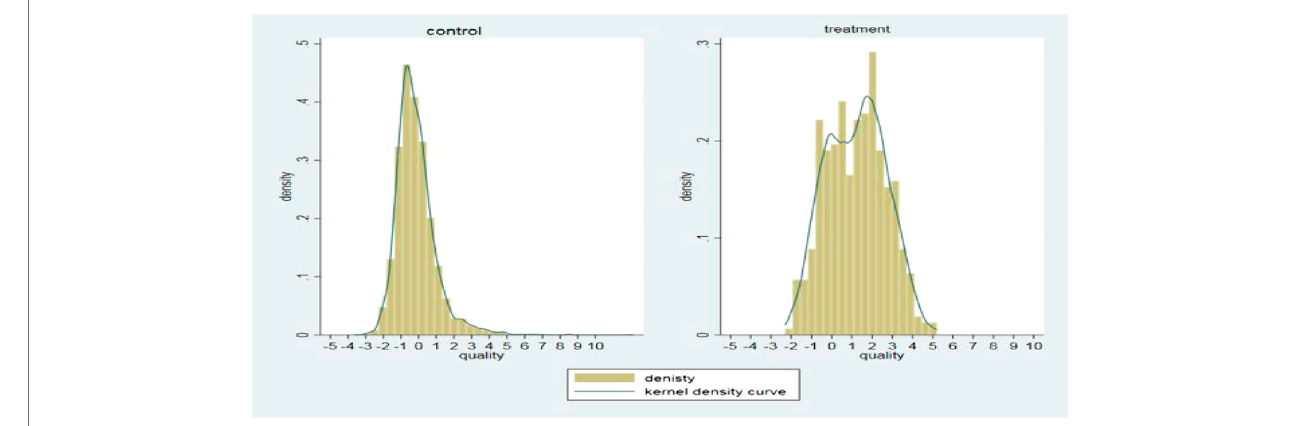
FIGURE 2 | Nuclear density map.